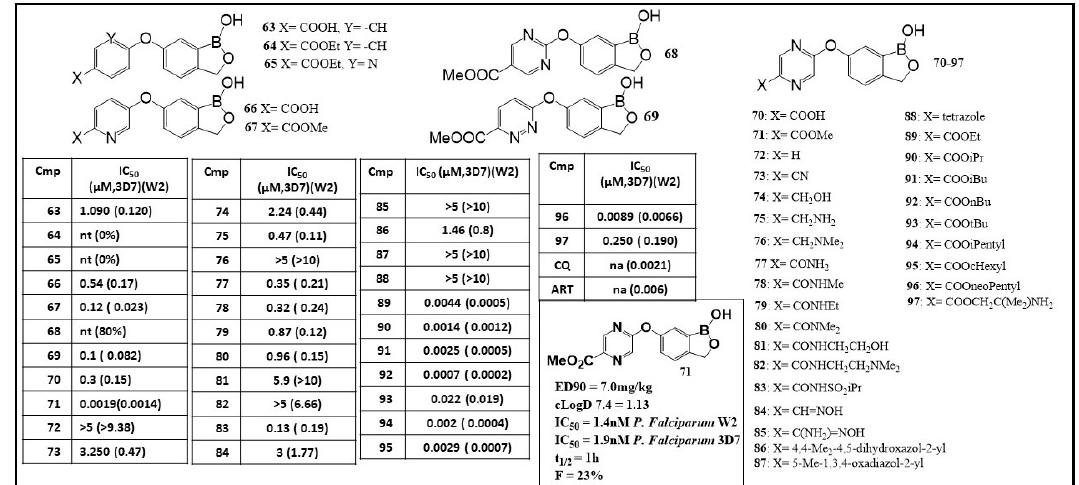
Figure 7. Structures and antimalarial activity (IC 50 ) of benzoxaboroles ( 63–97 ) against the malaria parasite Plasmodium falciparum CQ-sensitive 3D7 and CQ-resistant W2 strains. (Adapted from [85]).